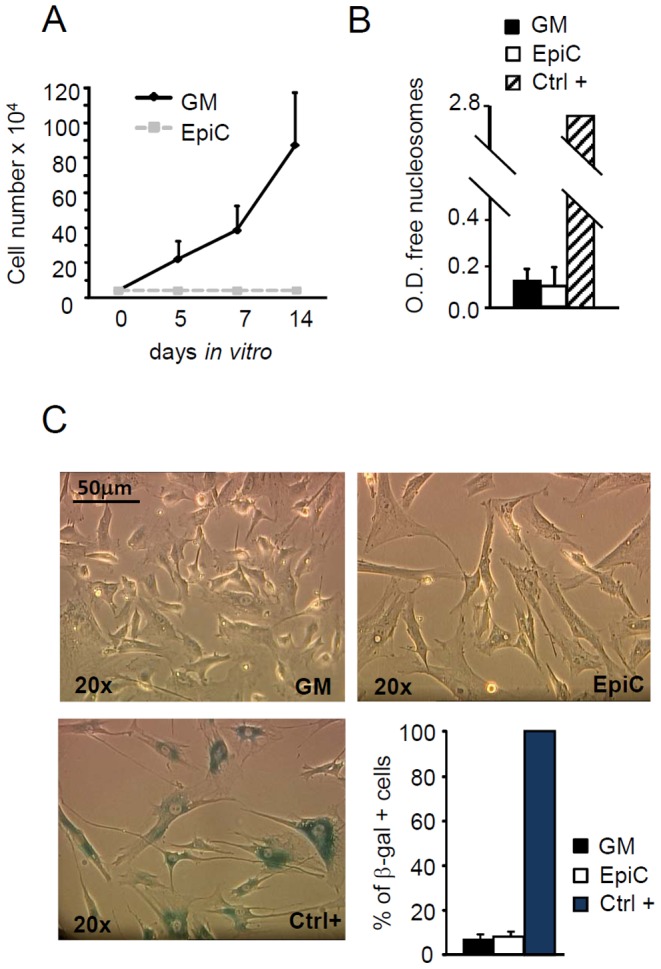
Effect of EpiC treatment on CStC growth, viability and senescence.(A) Growth curve of CStC cultured in GM or EpiC for 5, 7, and 14 days (n = 7). (B) Quantification of free nucleosomes, used as markers of apoptosis, in CStC exposed to GM or EpiC for7 days. Ctrl+ = positive control supplied by the manufacturer. (C) Staining for senescence-related acidic β-galactosidase (β-gal ) performed on CStC grown either in GM or in EpiC medium. Positivity for β-gal is indicated by the presence of a dark grey stain within the cytoplasm. Ctrl+ = primary bone marrow mesenchymal stromal cells at passage 10 (replicative senescence). Bar Graph shows average percentage of β-gal positive cells (n = 4). Original magnification: 20×.